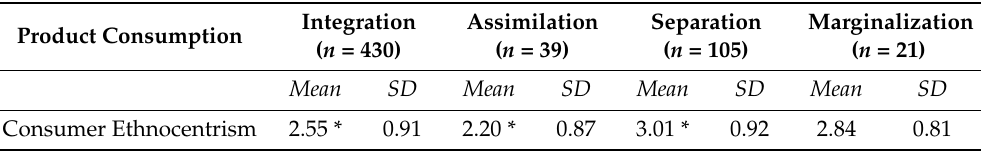
Table 2. Differences in Acculturation Modes by Consumer Ethnocentrism.